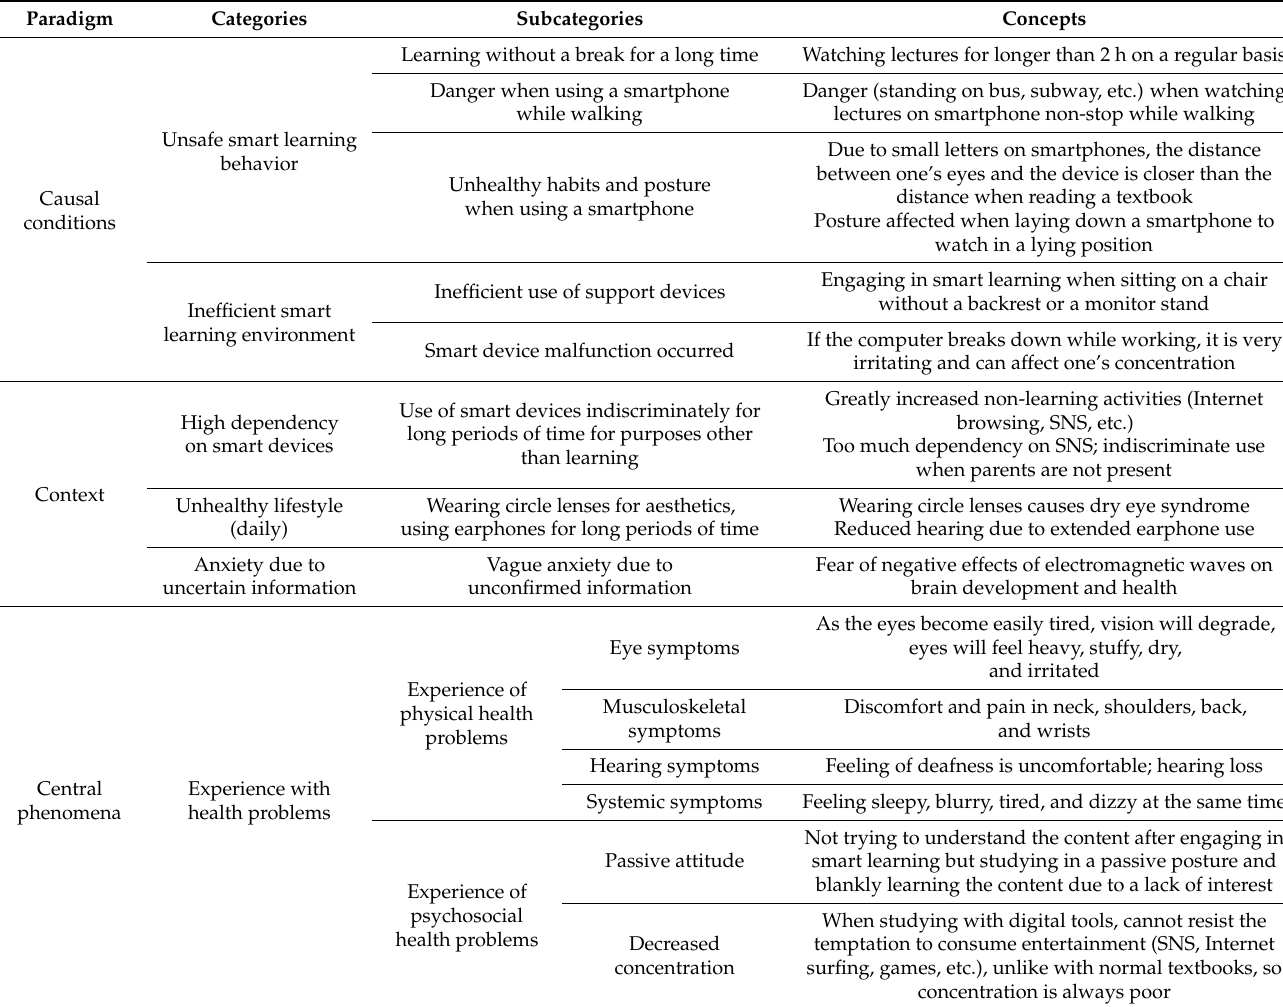
Table 2. Classification of identified health issues related to smart learning using the grounded theory